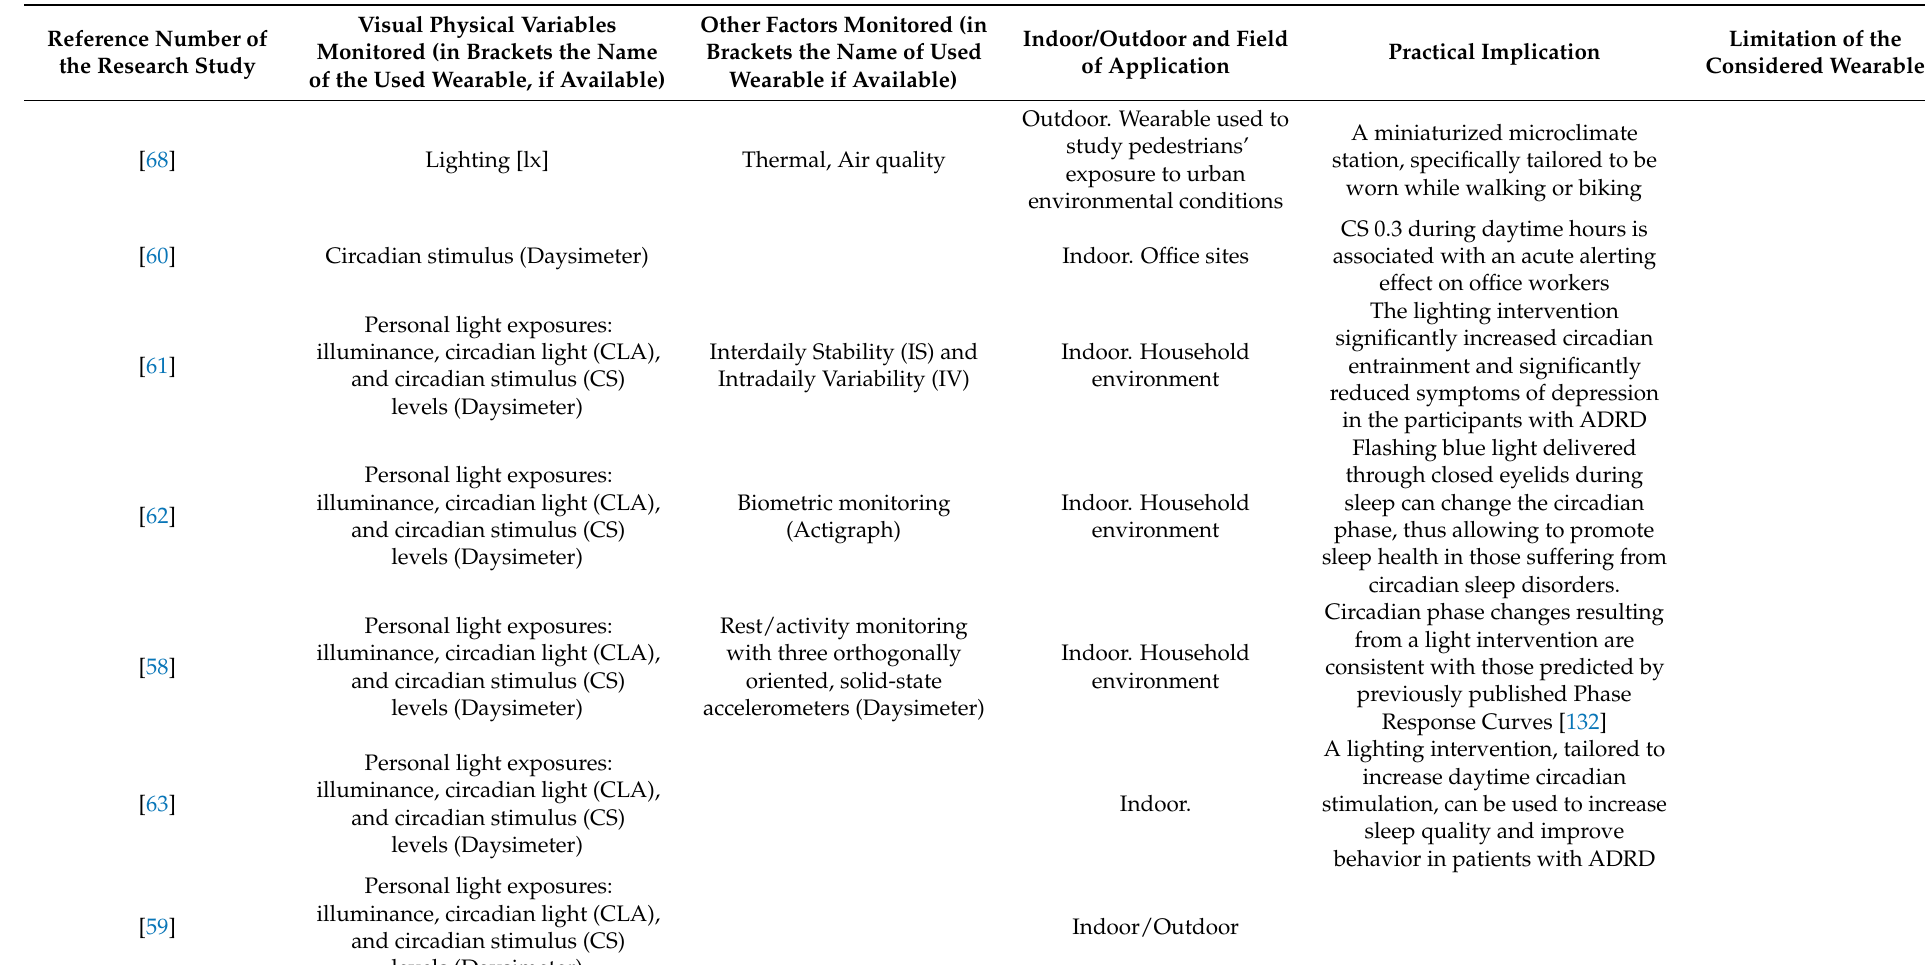
Table A1. Selected papers for visual